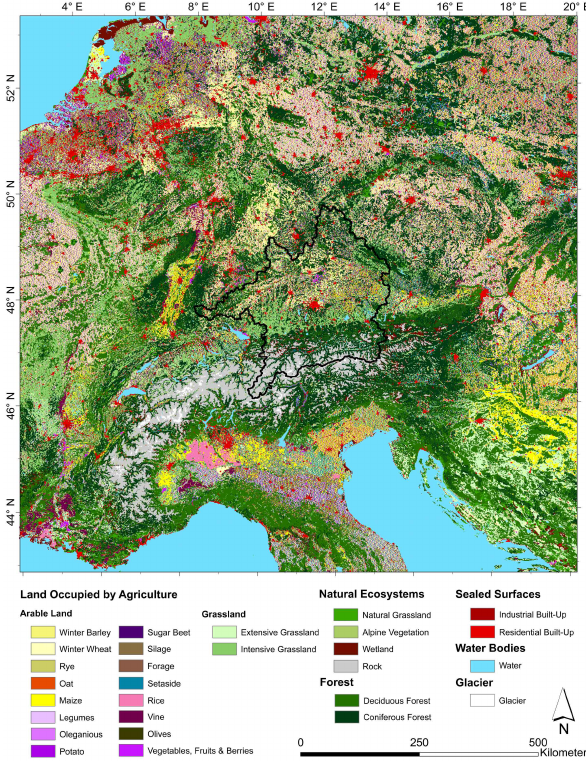
Fig. 7. Resulting land cover map based on CLC 2000 and CLC 1990 Switzerland and being transformed to the PROMET classi- fication, after phenological subclasses of arable land gathered by MERIS NDVI were further statistically reclassified with the help of the EUROSTAT